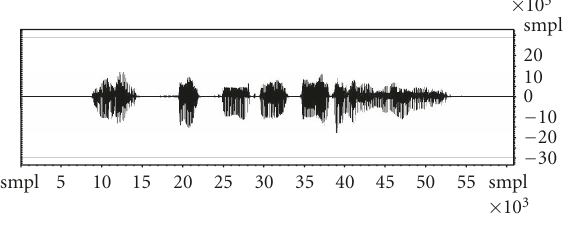
Figure 17: Normal speech long-term spectrum—close-talking mi- crophone.